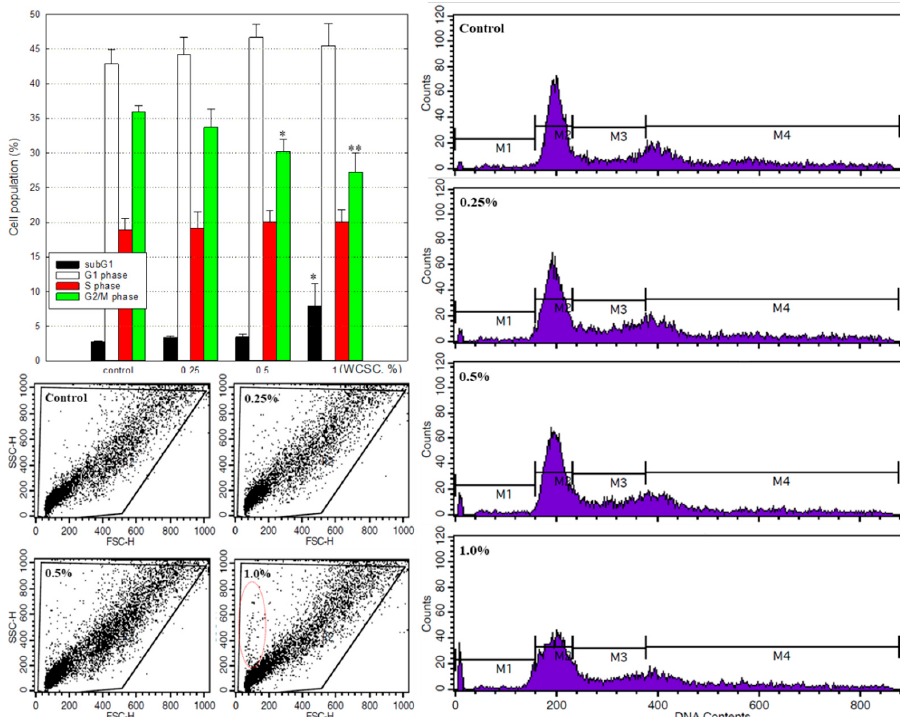
Figure 2. Imbalanced cell cycle regulation. Astrocytes were treated with WCSC in designated concentrations for 24 h. Treated and control cells were harvested, washed with PBS, and fixed in 70% ethanol overnight. After centrifugation, the cells were washed once with PBS and incubated in PBS containing 50 μ g RNase for 1 h at 37 °C, and the cells were then stained with 5 μ g PI. Experiment was independently performed three times (mean ± SD). * p < 0.05, ** p < 0.01.